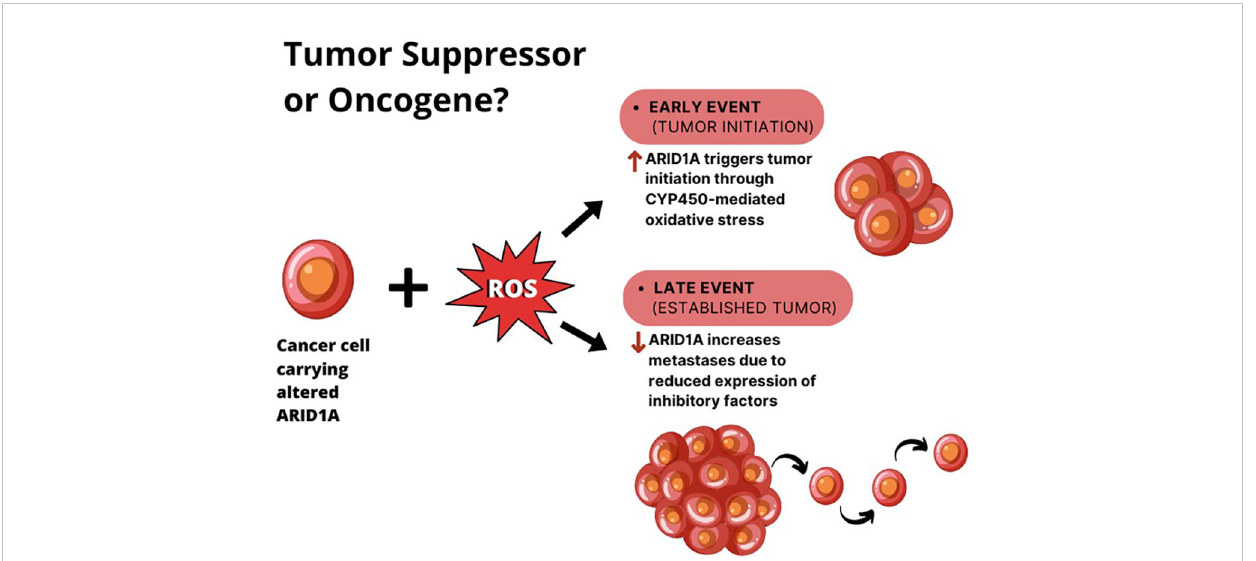
FIGURE 2 The double role of ARID1A in HCC. In the context of liver cell exposure to reactive oxygen species (ROS), ARID1A is overexpressed in cancer cells during tumor initiation, where it enhances tumor proliferation. When the tumor is established, ARID1A downregulation seems to elicit tumor